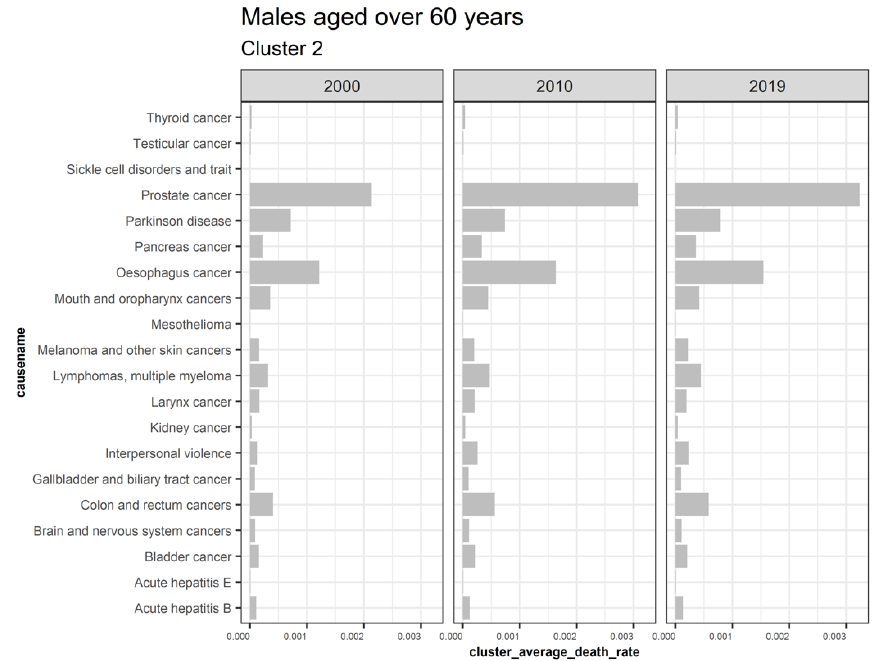
Figure 19. Increasing trend causes among older males in cluster 2 for 2000, 2010, and 2019.